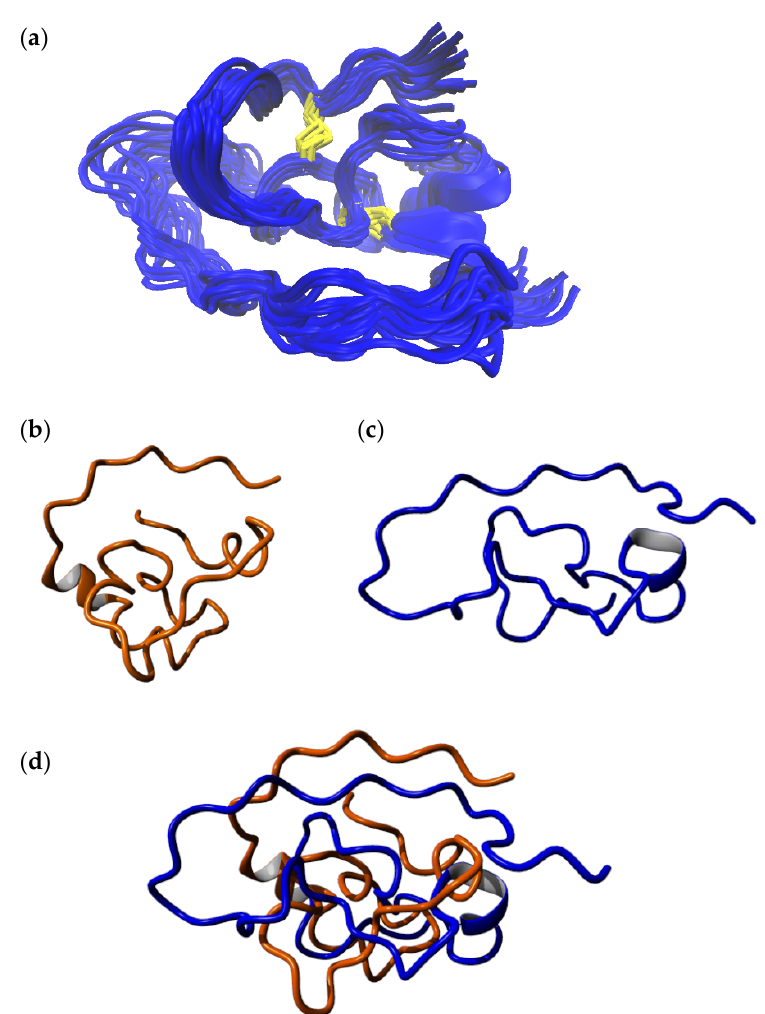
Figure 5. ( a ) The final 20 snapshots of the 300 ns MD simulation of the full-length model of isomer B [C19S,C25S] [29]. ( b ) Computationally derived structure of the same peptide analogue from an earlier study [29]. ( c ) Final snapshot from the 300 ns simulation from the current study. ( d ) Structural align- ment of the final structure from the 300 ns MD simulation from the current study (blue) with the com- putationally derived structure of the same peptide (orange) from an earlier study [29]. The alignment indicates that the two models essentially have varying structures while the underlying fold is pre- served. The computationally derived structure from earlier work has a more compact fold owing to the fact that it was created based on its three-disulfide-bonded parent, where residues Cys19 and Cys25 were linked by a disulfide bond. A fair alignment between the trailing end of the C-terminal segment is observed. The alignment was carried out using the MUSTANG algorithm [36].